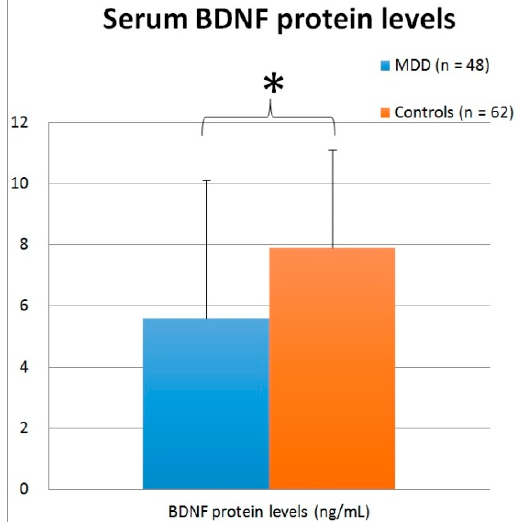
Figure 3. Serum BDNF protein levels (ng/mL) in patients with MDD and the healthy controls. (* p < 0.05)